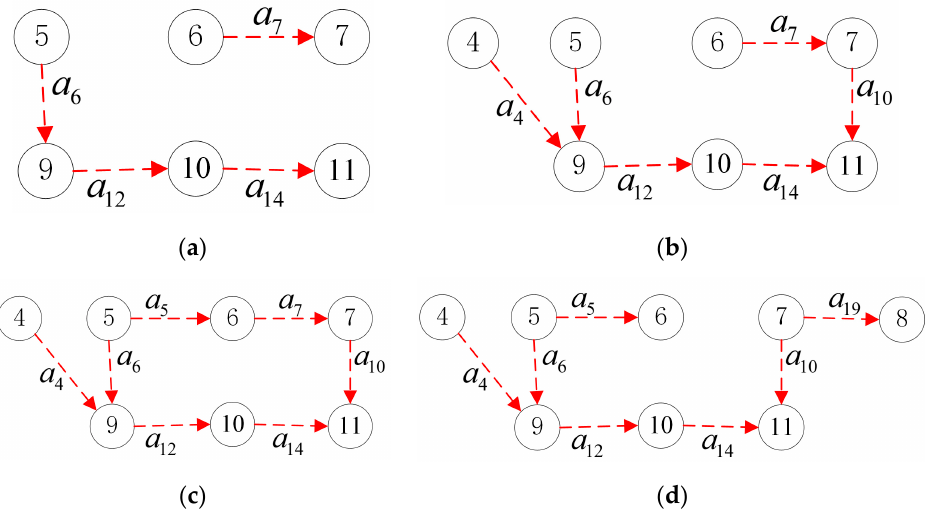
Figure 10 . EBL allocation scheme under different demands. ( a ) Figure 10. EBL allocation scheme under different demands. ( a ) λ = 0.5 ( b ) λ = 1 ( c ) λ = 1.5 ( d ) λ = 2, λ = 2.5, λ = 3.